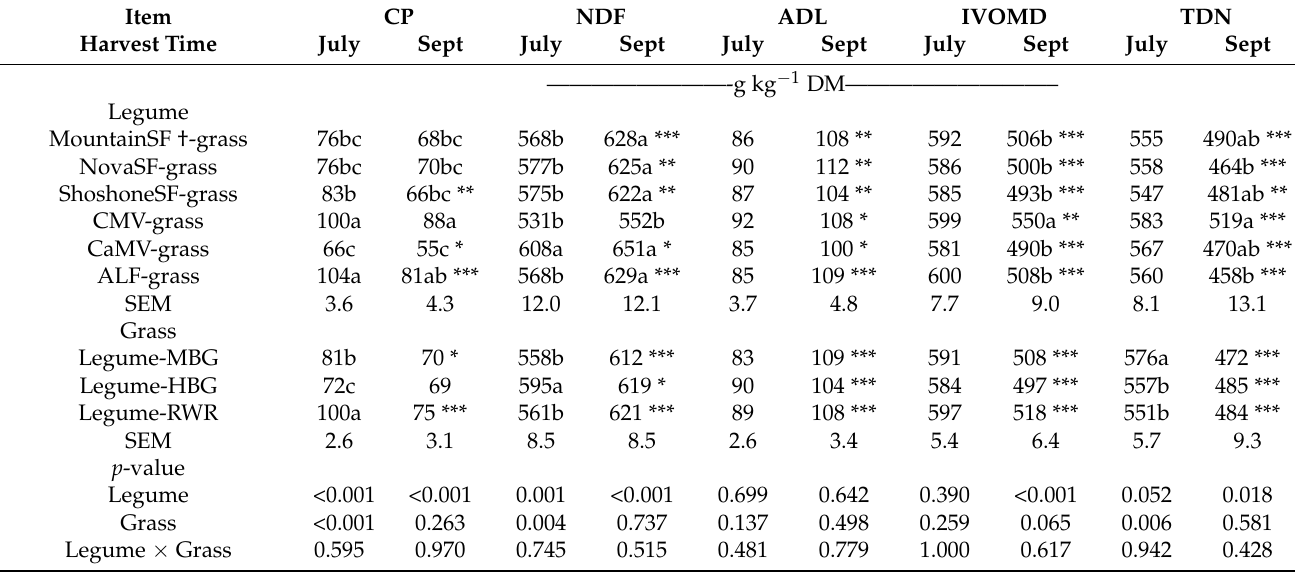
Table 4. Nutrient composition and digestibility of legume-grass binary mixtures at July and September harvest at Saskatoon, Saskatchewan,